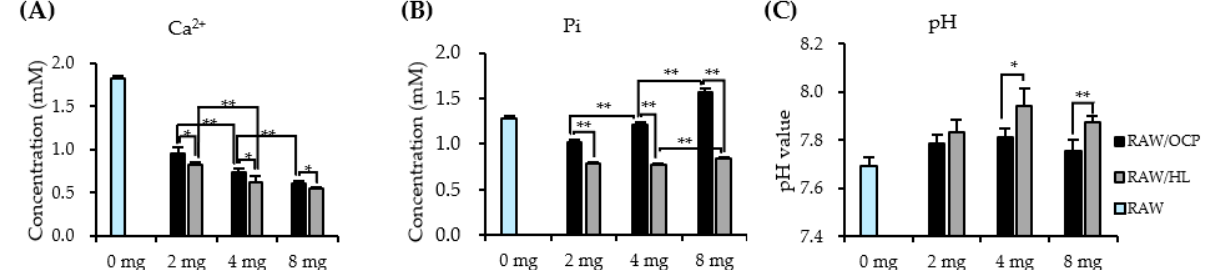
Figure 7. Dose response of CaP materials on the changes in the concentration of Ca 2+ ( A ), Pi ( B ), and pH ( C ) in the macrophage cultured DMEM. ( n = 4). The data of the ionic concentration and pH value of RAW (0 mg) group is used from Figure 6. ** p < 0.01, * p < 0.05. The RAW (0 mg) group is statistically significantly different from other groups in terms of Ca 2+ concentration (all material groups), Pi concentration (all material groups), and pH value (RAW/OCP 2, 4 mg; RAW/HL 2, 4, 8 mg).